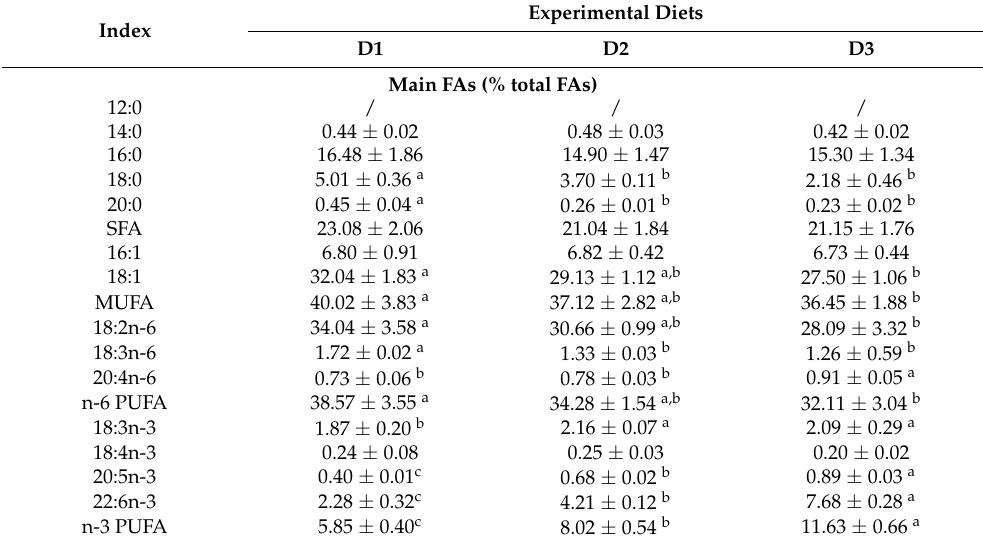
Table 4. FA composition of muscle in common carp with different dietary treatments after 8 weeks.